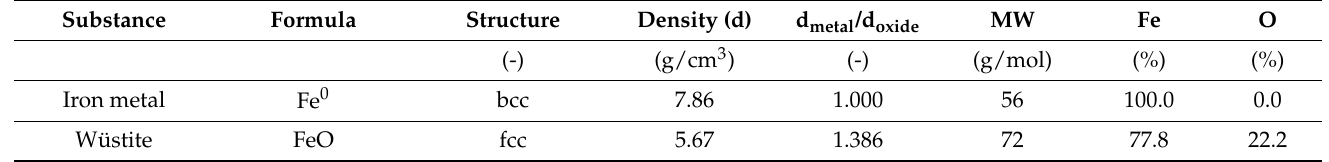
Table 1. Structure, formula, and some characteristics of metallic iron (Fe 0 ) and its main corrosion products. Data are compiled from Balasubramaniam et al. [92] and Car é et al. [93]. bcc stands for body-centered cubic, and fcc stands for face-centered cubic. d iron /d oxide gives an indication of the extent of volumetric expansion, while the percent Fe gives an idea of the decrease in the electronic conductivity of oxides relative to Fe 0